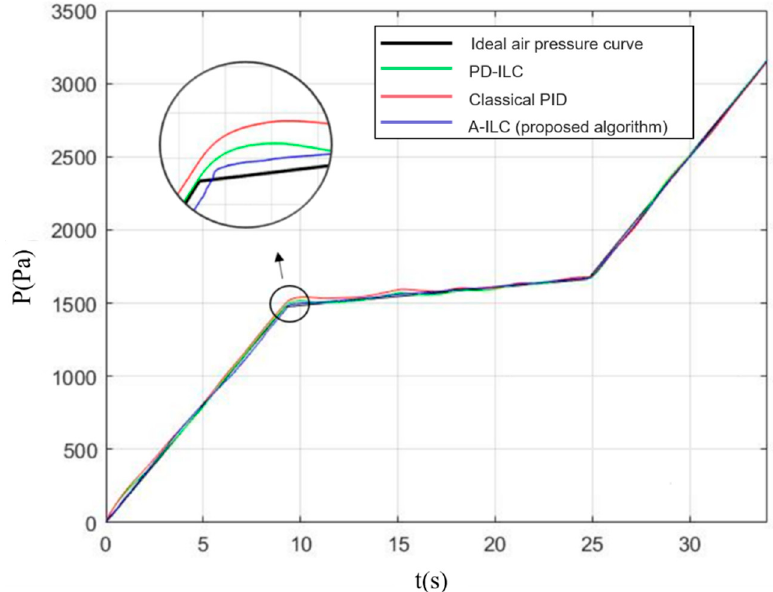
Figure 18. Comparison of the air pressure compensation methods.